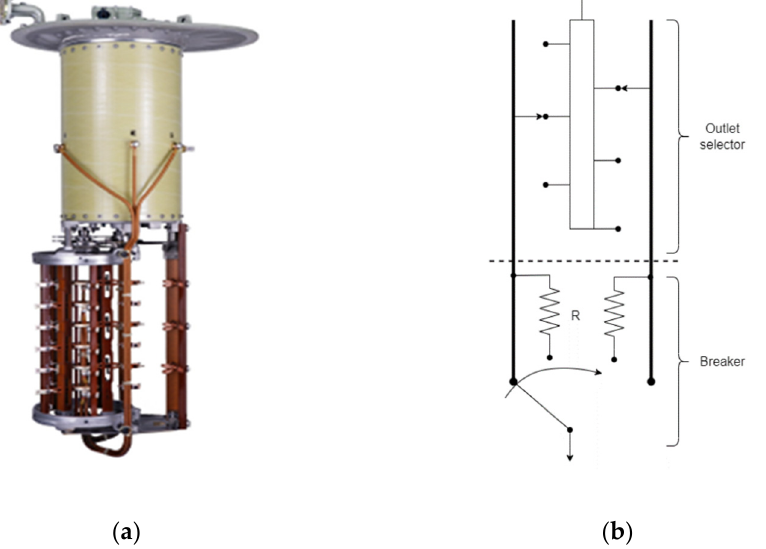
Figure 9. On-load tap-changer. ( a ) tap-changer device commercially available; ( b ) diagram of the tap-changer working principle.